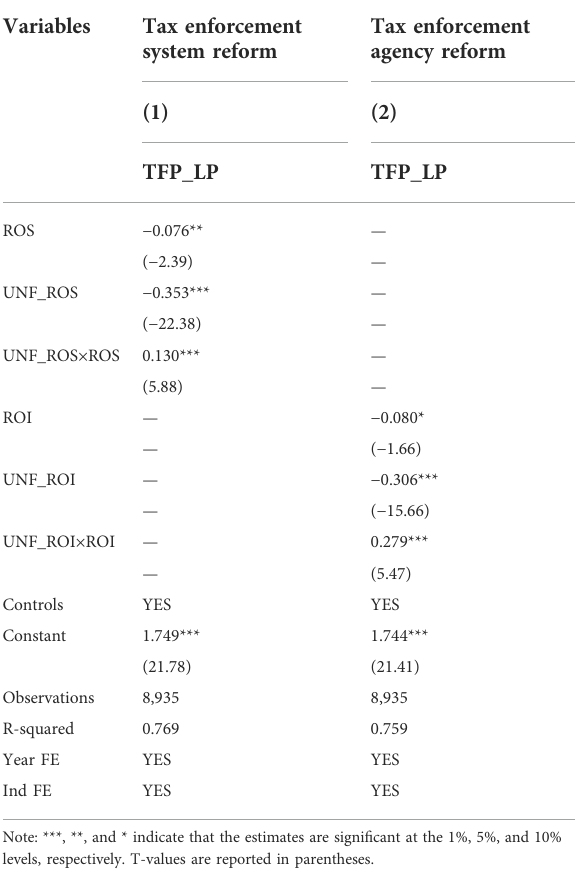
TABLE 5 Baseline regression